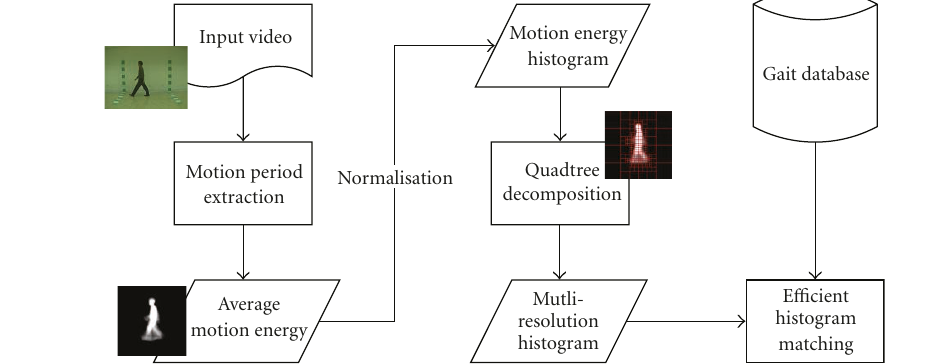
Figure 1: System Overview.